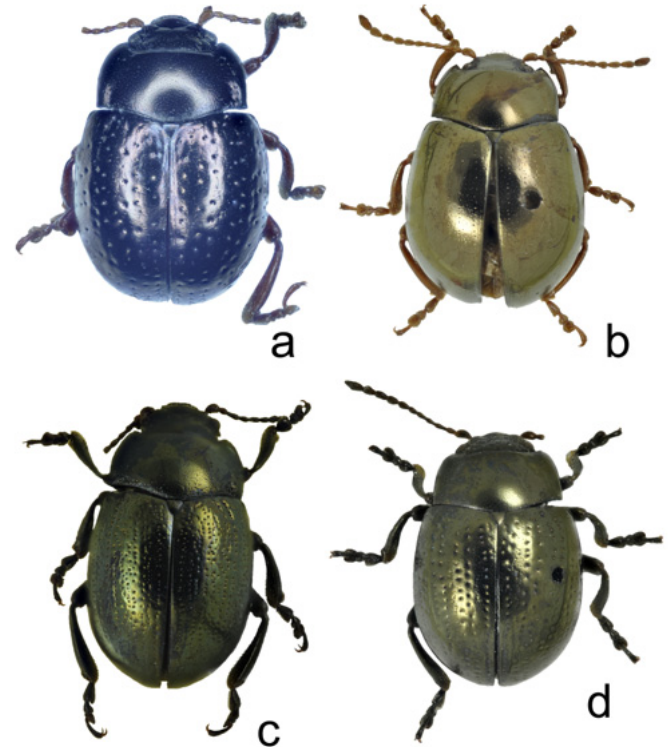
Figure 7. Chrysolina , total dorsal view: ( a ) Ch. fascinatrix , holotype, male; ( b ) Ch. liqingzhaoae , paratype, male; ( c ) Ch. wangi , holotype, male; ( d ) Ch. marinae sp. nov., holotype, male.